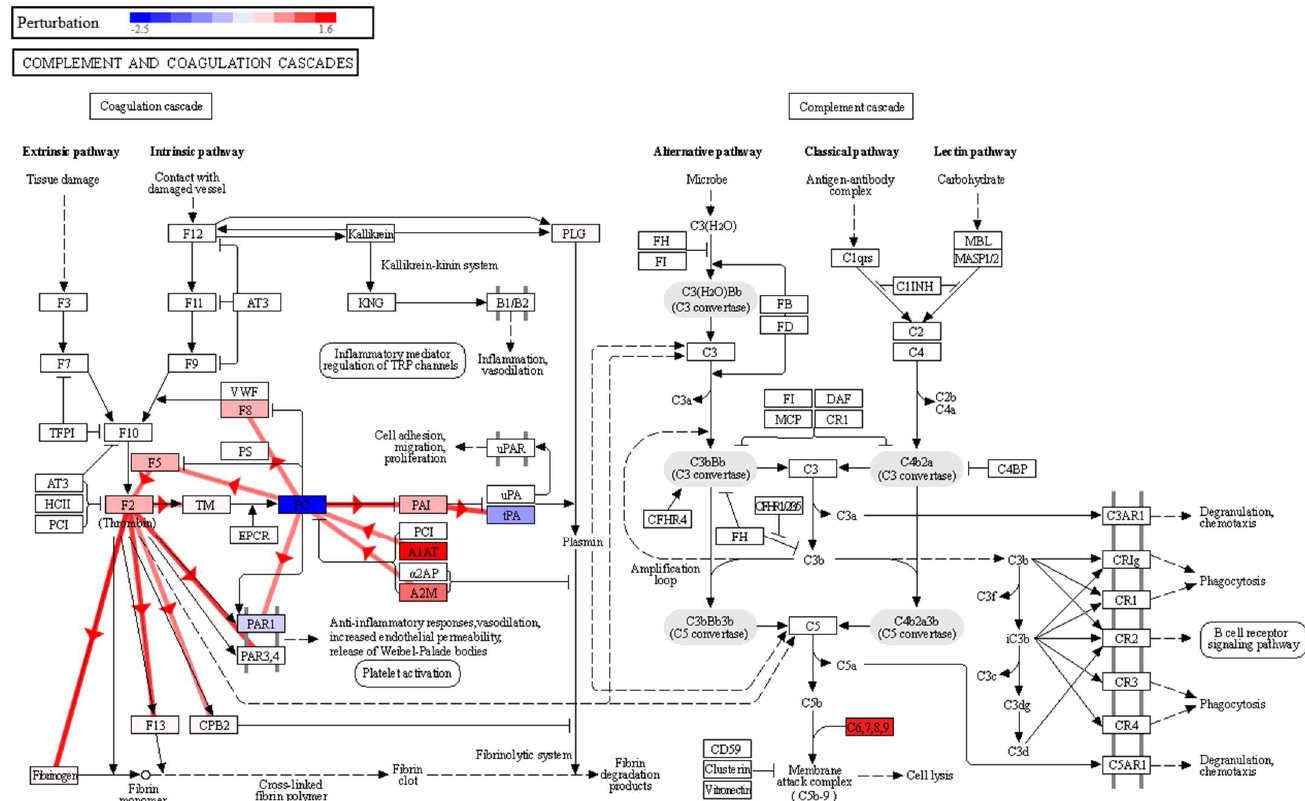
Figure 3. Effect of lung cancer alteration on the sputum proteome, on the complement and coagulation cascades pathway (KEGG:05171), highlighting protein perturbation according to our quantification results and showing coherent cascades.